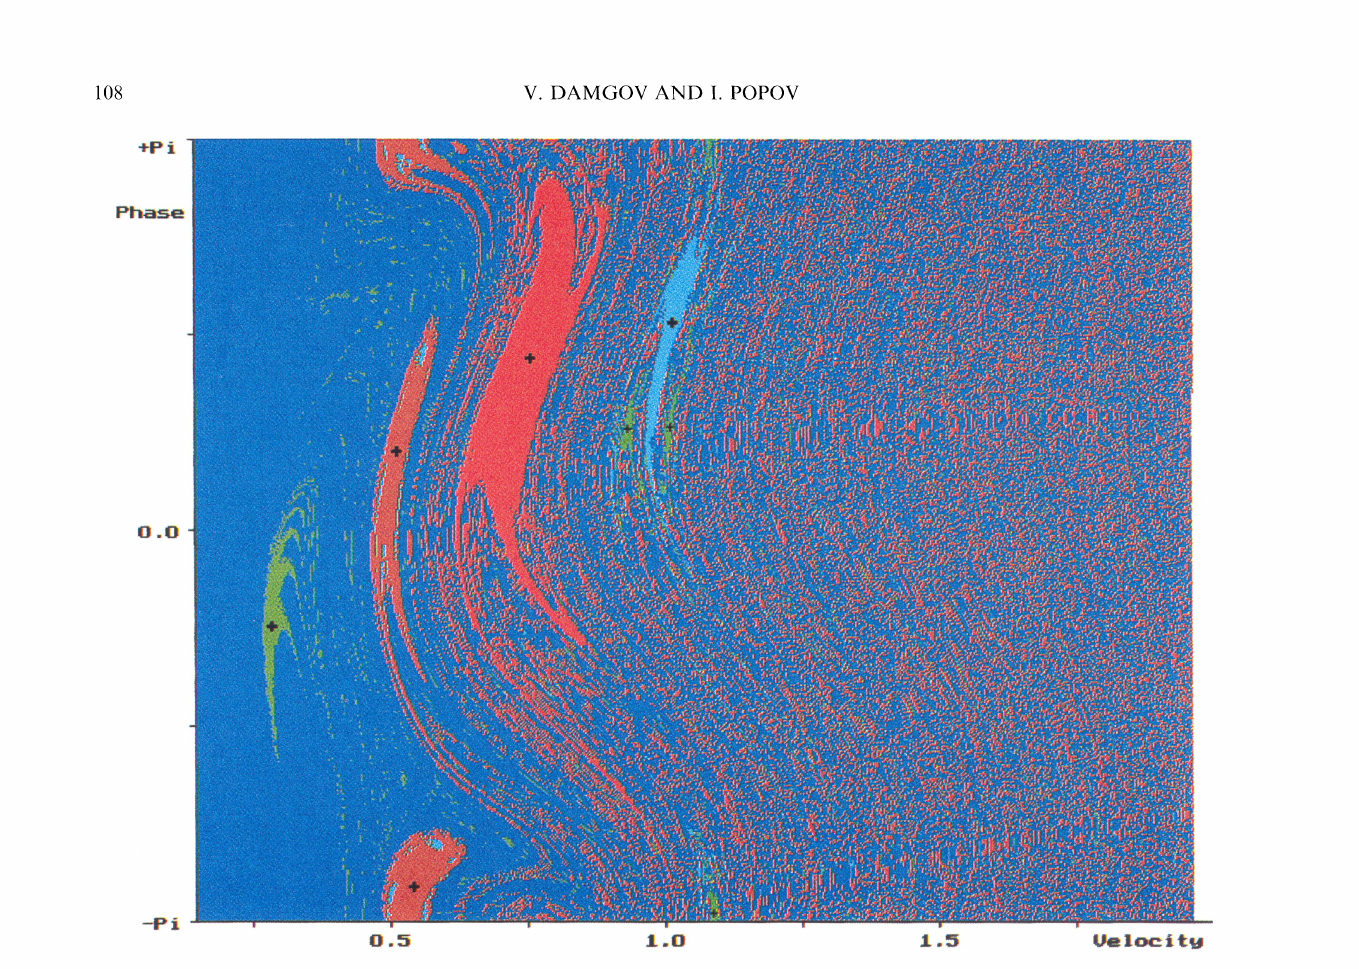
FIGURE 5 FPs, periodical points and their basins of attraction of the kicked pendulum at F:-3.4. (Sec Color Plate